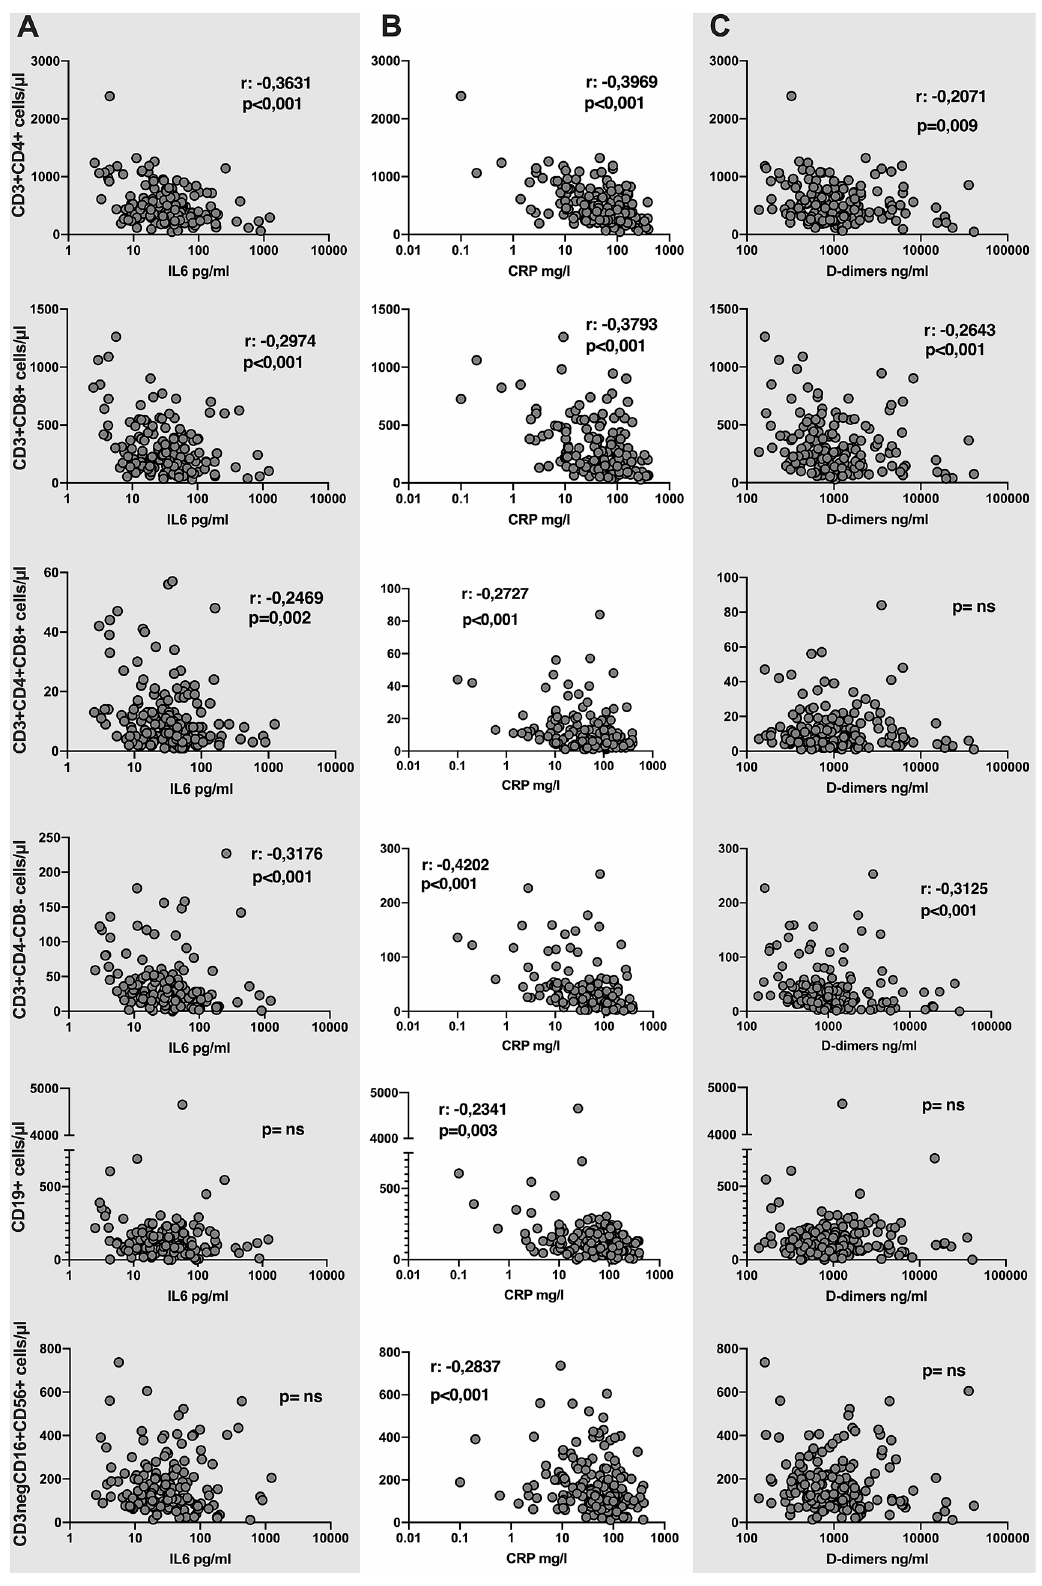
Figure 4. Correlation between lymphocyte subpopulation absolute counts and inflammation markers. Absolute counts of total T-lymphocytes and related subsets (CD3 + CD4+, CD3 + CD8+, CD3 + CD4 + CD8 + DP, CD3 + CD4 − CD8 − DN), B-lymphocytes and NK-cells (CD16 + CD56+) were correlated with IL-6 (column A), CRP serum concentrations (column B) and d-dimer plasma concentration (column C). Correlation was assessed with the Spearman’s test; Spearman r (only if statistically significant) and p are reported in the boxes; a two-sided p value of < 0.05 was considered statistically significant. ns not statistically significant, IL-6 interleukin-6, CRP C-reactive